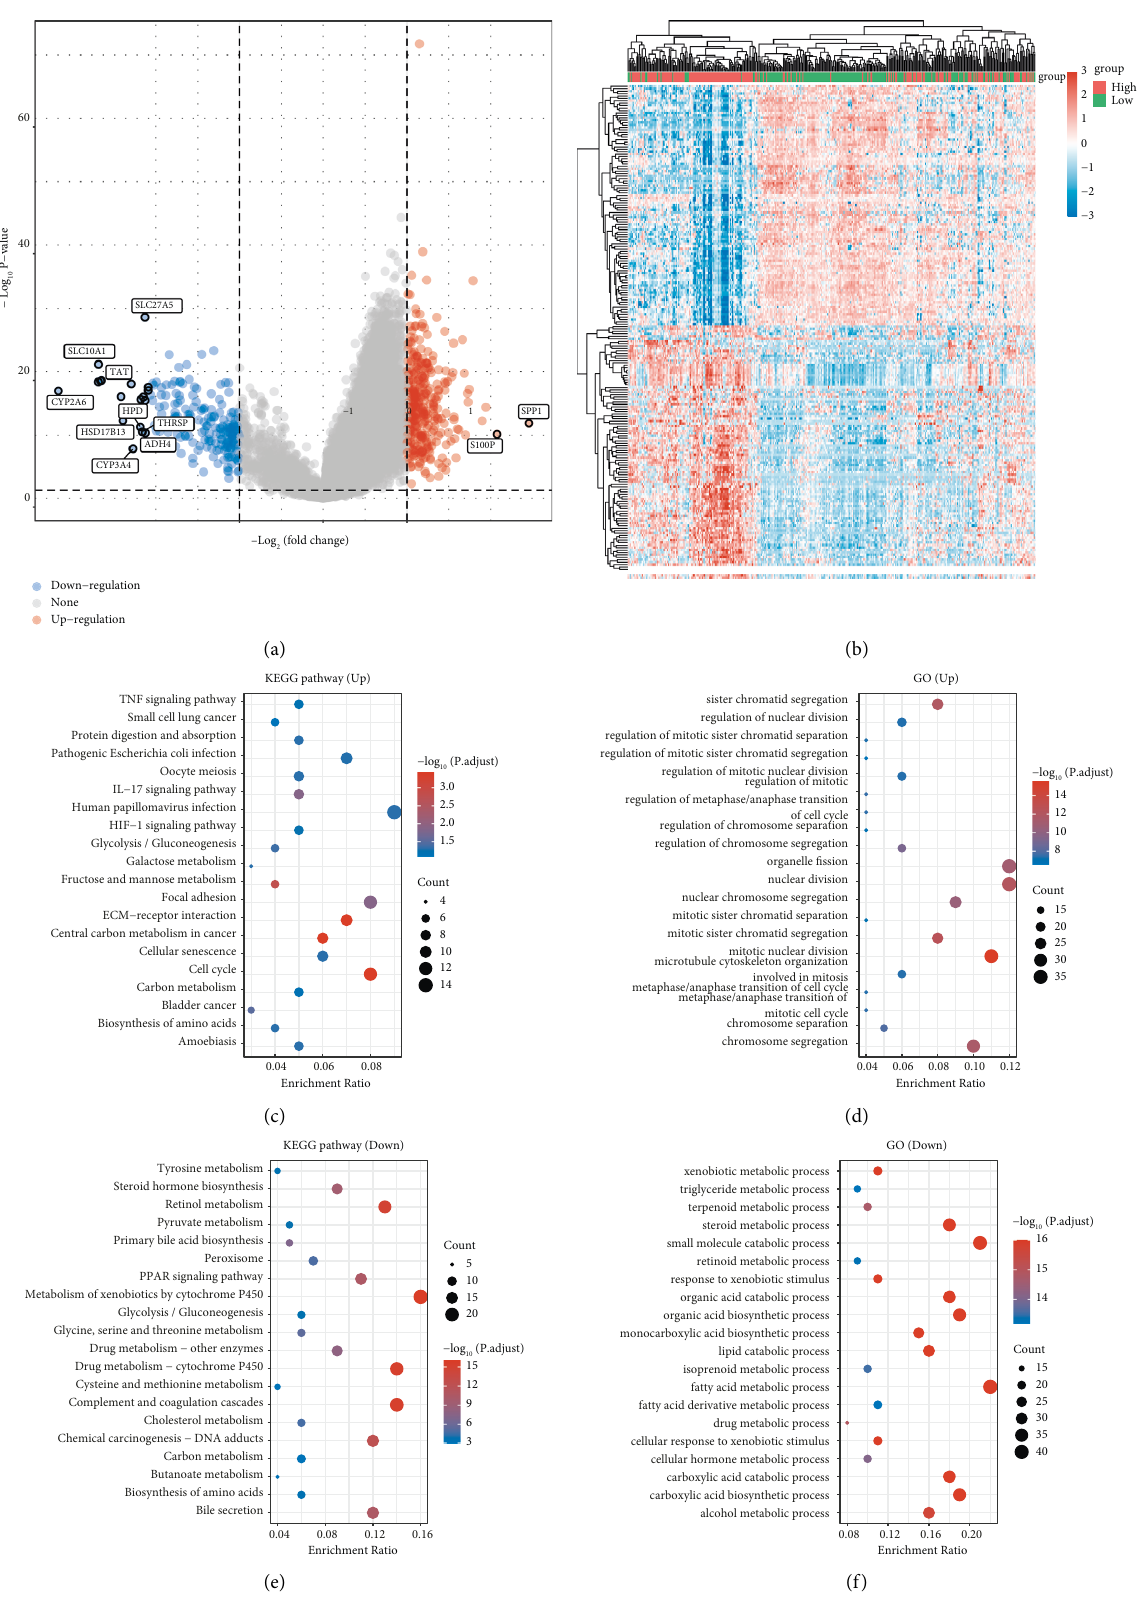
Figure 3: Identification of DEGs and GO, and KEGG pathway enrichment analysis. (a) Volcano plot of DEGs. (b) Heatmap of DEGs. (c, d) KEGG and GO enrichment analysis on upregulated DEGs. (e, f) KEGG and GO enrichment analyses on downregulated